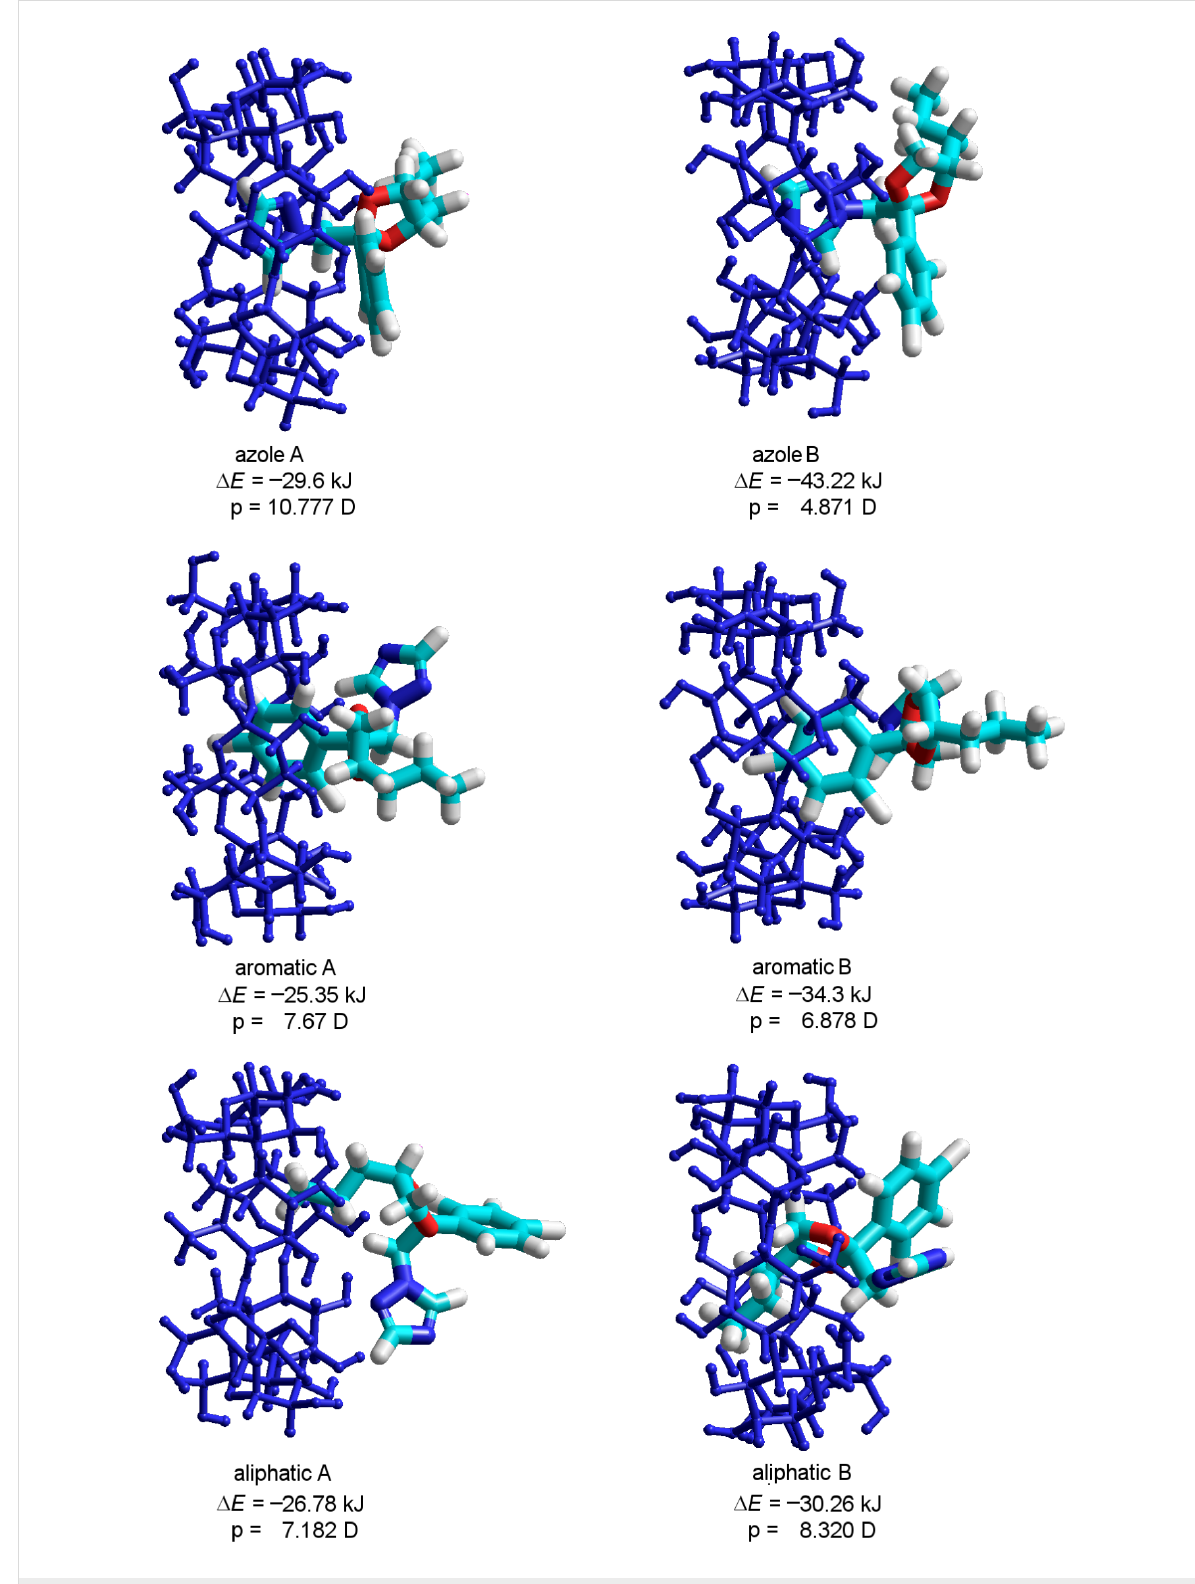
Figure 2: PM3 optimized molecular geometries of the β -CD/PP inclusion compounds involved in the assessment of PP inclusion into the β -CD cavity by each of its